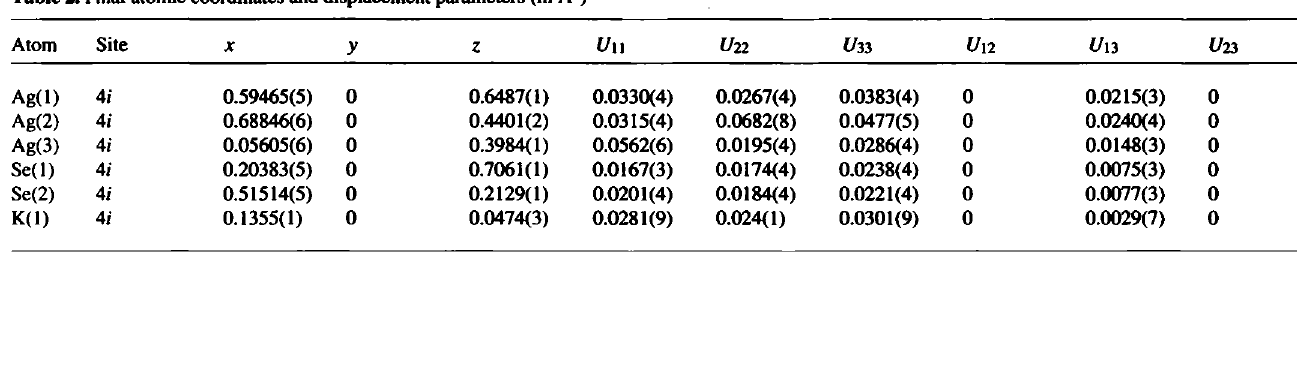
Table 2. Final atomic coordinates and displacement parameters (in Â 2 ) Atom Site